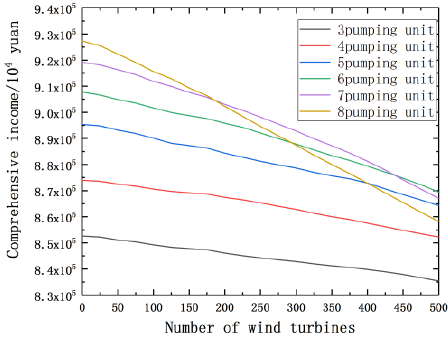
Figure 7. Capacity allocation comprehensive income of strategy 1.